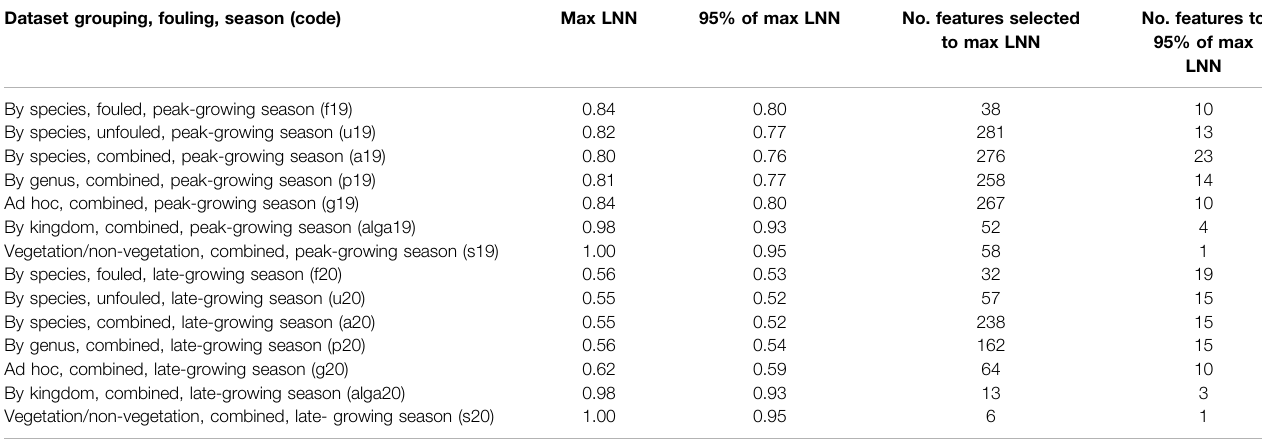
TABLE 1| Results oftheforward featureselectionalgorithmforthefullresolutionASDspectra.The95%ofmaximumLNNcriterionvalueandnumber offeaturesrequired to produce 95% of the maximum separability are included as many selected features provide only marginal gains in separability. Dataset grouping, fouling, season (code) Max LNN 95% of max LNN No. features selected